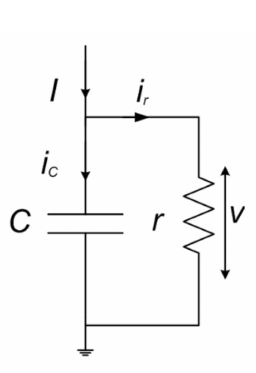
Figure 1. EV battery analogic